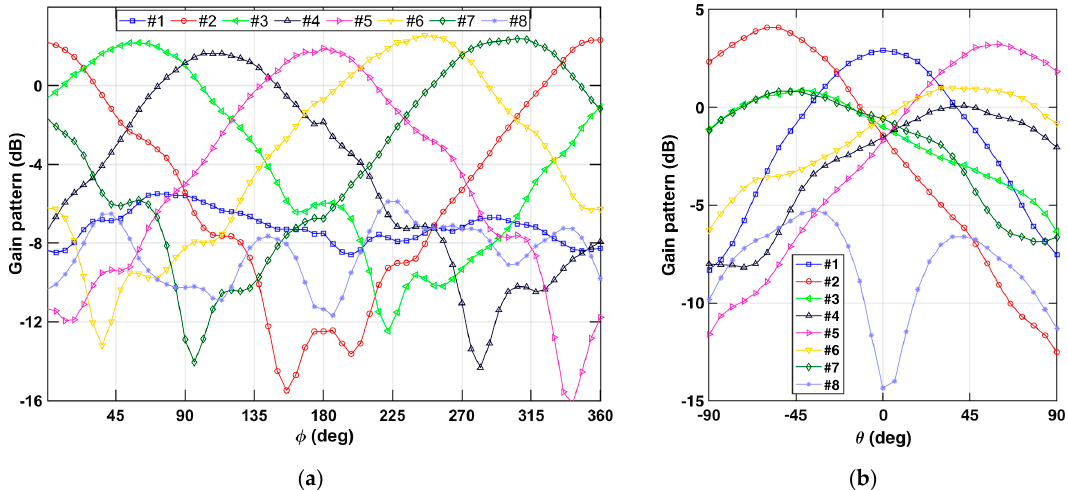
Figure 3. Switched Beam Antenna prototype: ( a ) upper view; the top antenna in this realization presents some parasitic elements to improve the radiation gain of antenna #8; ( b ) rear view, with the control unit board in view.